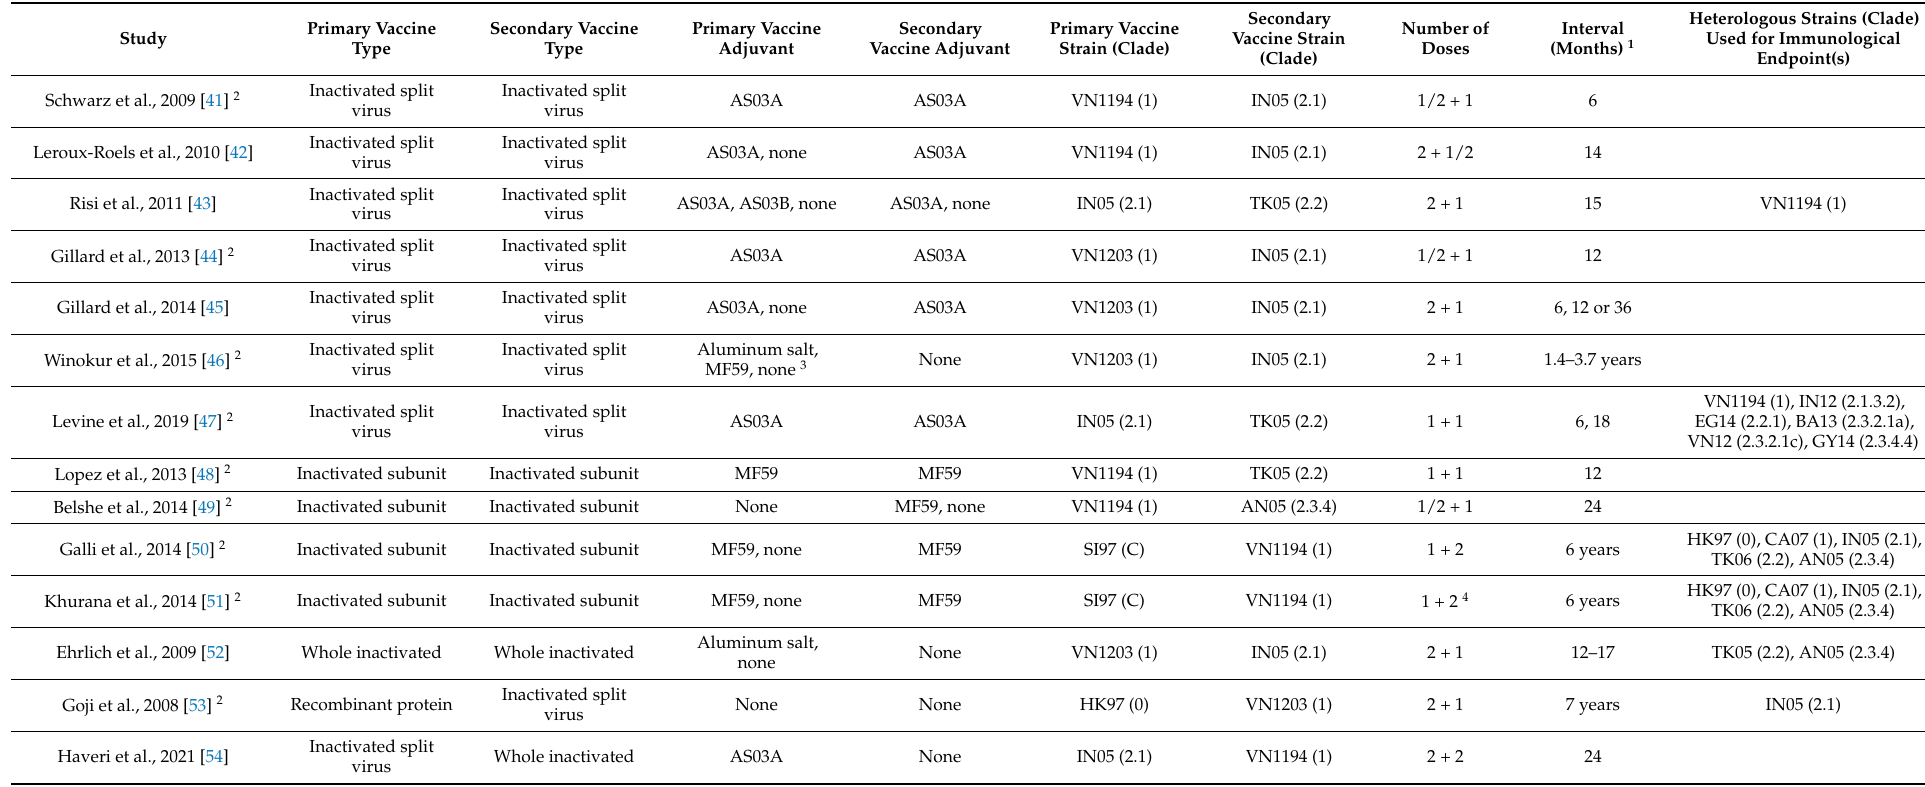
Table 2. Overview of the articles selected for the heterologous prime-boost vaccination